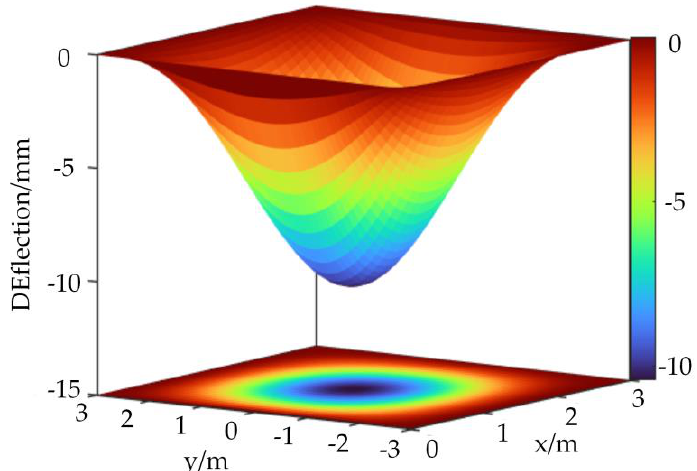
Figure 2. Deflection distribution characteristic of unsupported roof in heading face.